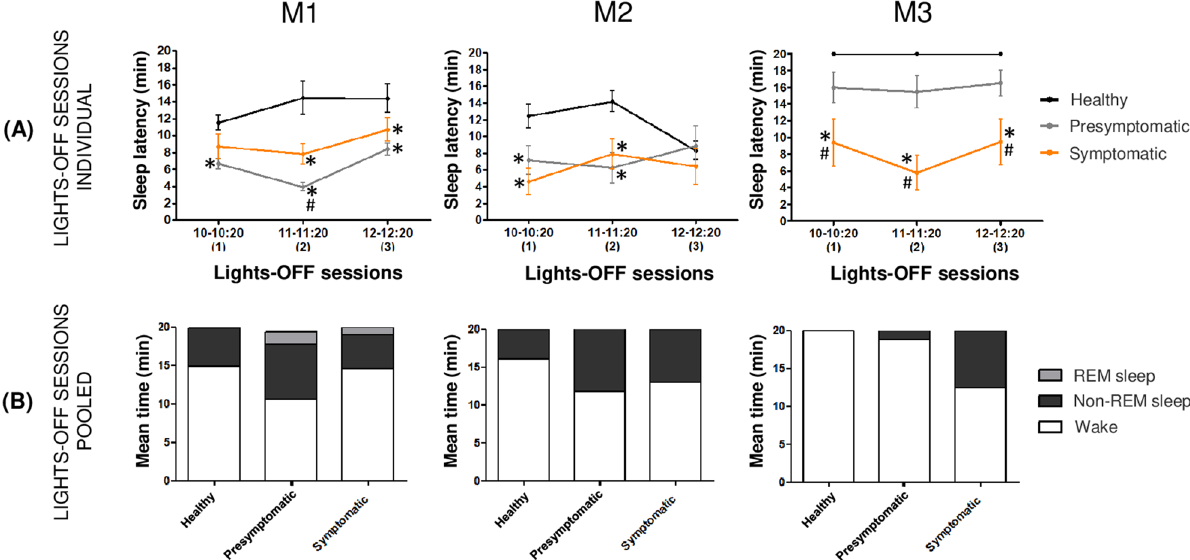
Figure 4. Panel of different sleep parameters obtained in lights-OFF sessions of each animal during healthy, presymptomatic and symptomatic states. ( A ) SL expressed in min for each lights-OFF session (1) from 10 a.m. to 10:20 a.m., (2) from 11 a.m. to 11:20 a.m., (3) from 12 a.m. to 12:20 a.m. and during healthy (black line), presymptomatic (grey line) and symptomatic (orange line) states. ( B ) Mean time of wake (white), non- REM sleep (N1-N2-N3) (black) and REM sleep (grey) duration for all lights-OFF session pooled together during healthy, presymptomatic and symptomatic states. P < 0.05 * different from healthy state; #